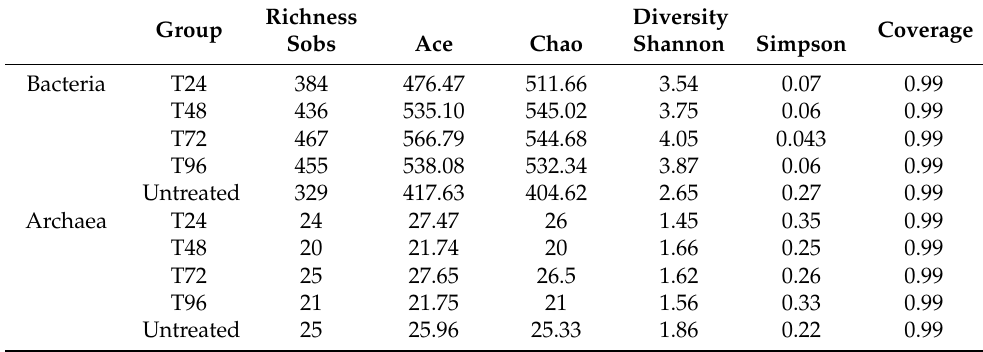
Table 3. Microbial community richness and diversity in different pretreatment groups.